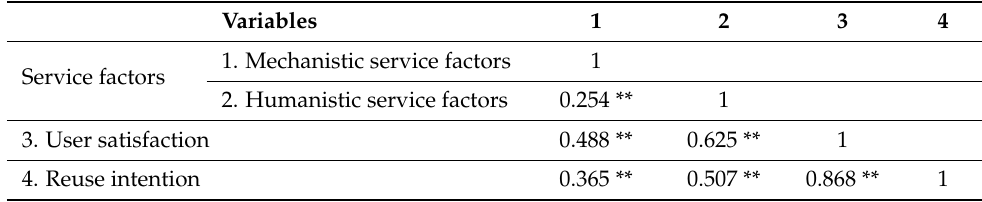
Table 8. Pearson correlation analysis between